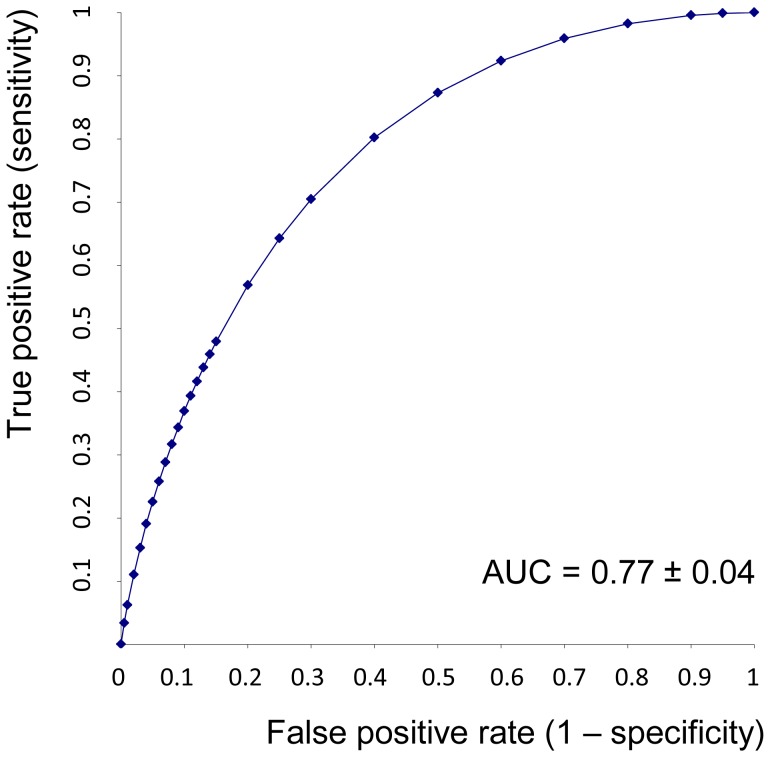
ROC curve of BLVRA expression in peripheral blood leukocytes of HCV infected patients.AUC, area under the ROC curve; ROC, Receiver Operating Charasteristic.